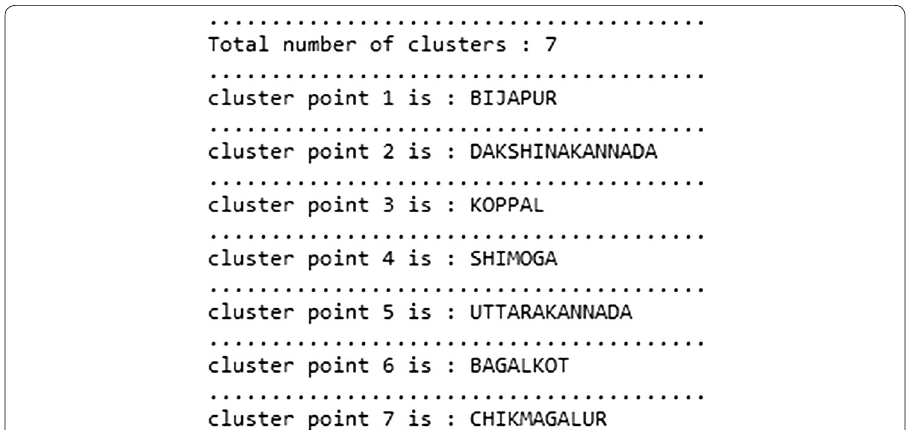
Fig. 4 Cluster centres obtained from the Batchelor Wilkins